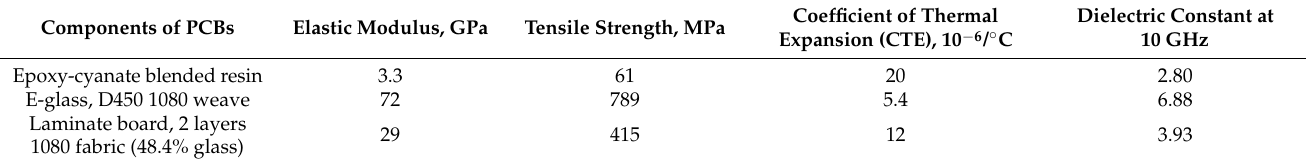
Coefficient of Thermal Dielectric Constant at Expansion (CTE), 10 − 6 / ◦ C 10 GHz